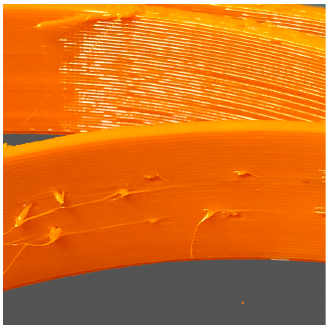
Figure 13. Blobs and zits marks on outer shell surface of the part.